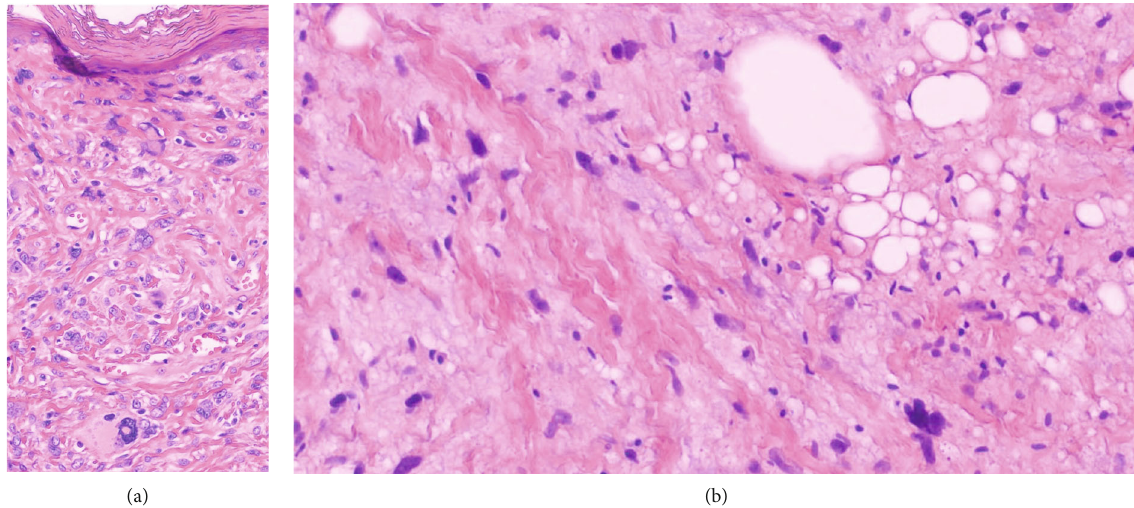
Figure 4: (a) Con fl uence of pleomorphic cells within the papillary dermis (H&E, 400x). (b) Thickened ropey collagen with myxoid stroma, pleomorphic cells, and variable lipoblasts (H&E,